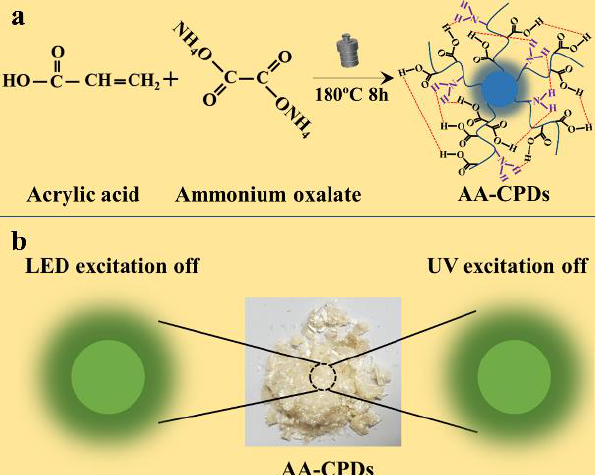
Figure 1. ( a ) Synthetic route of AA-CPDs. ( b ) Schematic illustration of AA-CPDs with WLED and UV excitation (365 nm).